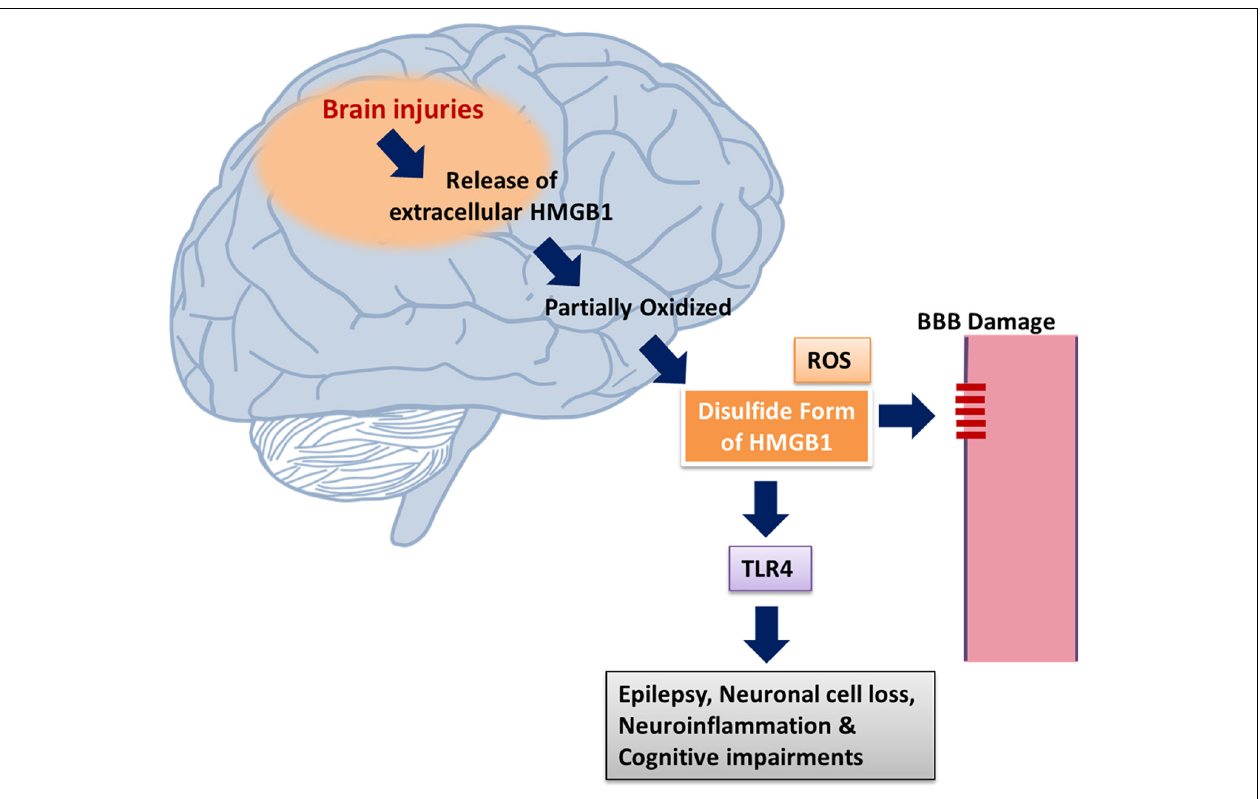
FIGURE 2 | Mechanism of HMGB1 release via brain injury. HMGB1 translocation results from brain injuries and epileptogenesis. Dying cells, neurons and glia are responsible for the release of extracellular HMGB1 which can be partially oxidized. Neuronal excitability is enhanced via the mediation of pro-inflammatory activities through the activation of TLR4 signaling by disulphide HMGB1. The stabilization of HMGB1 in its disulphide form is promoted by the generation of ROS. HMGB1 via activating receptors RAGE and TLR4 leads to neuronal cell loss, neuroinflammation, epilepsy, and cognitive dysfunction (Ravizza et al.,